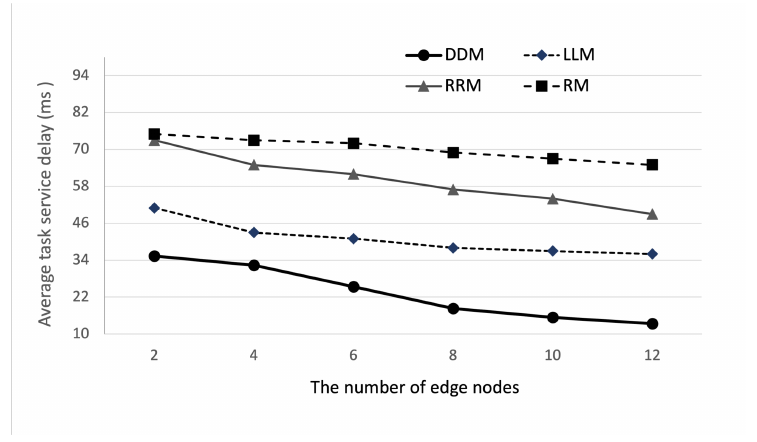
Figure 7. Average task service delay according to the number of edge nodes.